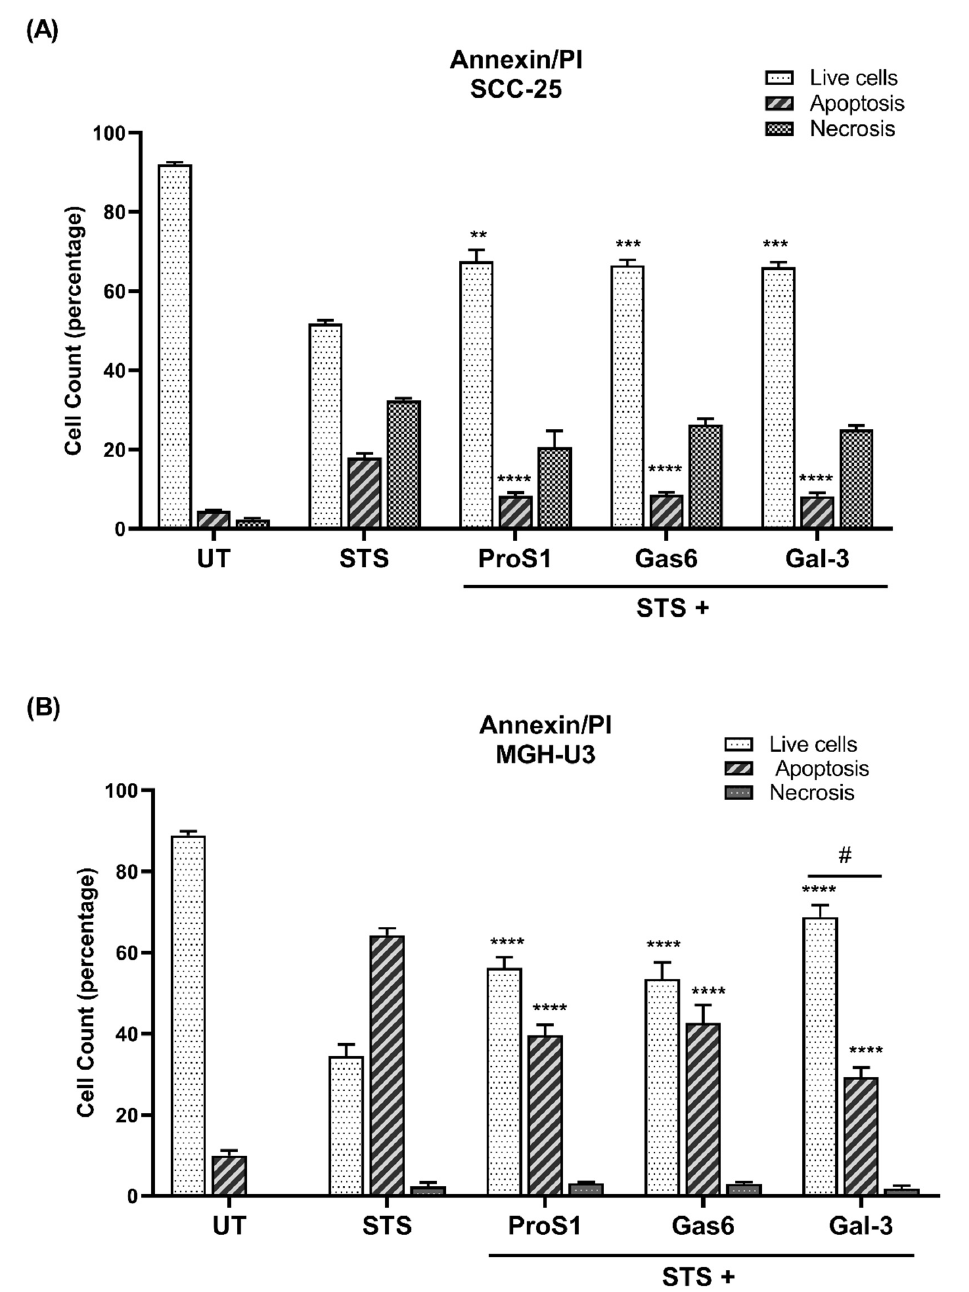
Figure 5. Effect of Gal-3 on cancer cells undergoing apoptosis and role of the TAM receptor expression profile in mediating these effects. Flow cytometry results showing percentage of SCC-25 ( A ) and MGH-U3 ( B ) cells undergoing apoptosis (Annexin V-FITC/PI double-stained) by 20 h incubation with staurosporine (STS; 0.1 μ M), with co-incubation with Gal-3 and TAM ligands added 1 h previously. Graphs show proportions (%) of healthy, apoptotic and necrotic cells. Data are the mean ± SEM and underwent ANOVA with Tukey’s multiple comparison post-hoc analysis; **** p < 0.0001, *** p < 0.001, ** p < 0.01 versus the same category of cells in the STS alone treated group ( n = 3 experiments). (#) indicates the comparisons between Gal-3 cell fraction versus the same category of cells in both Gas6 and ProS1 treatment groups; p < 0.05.